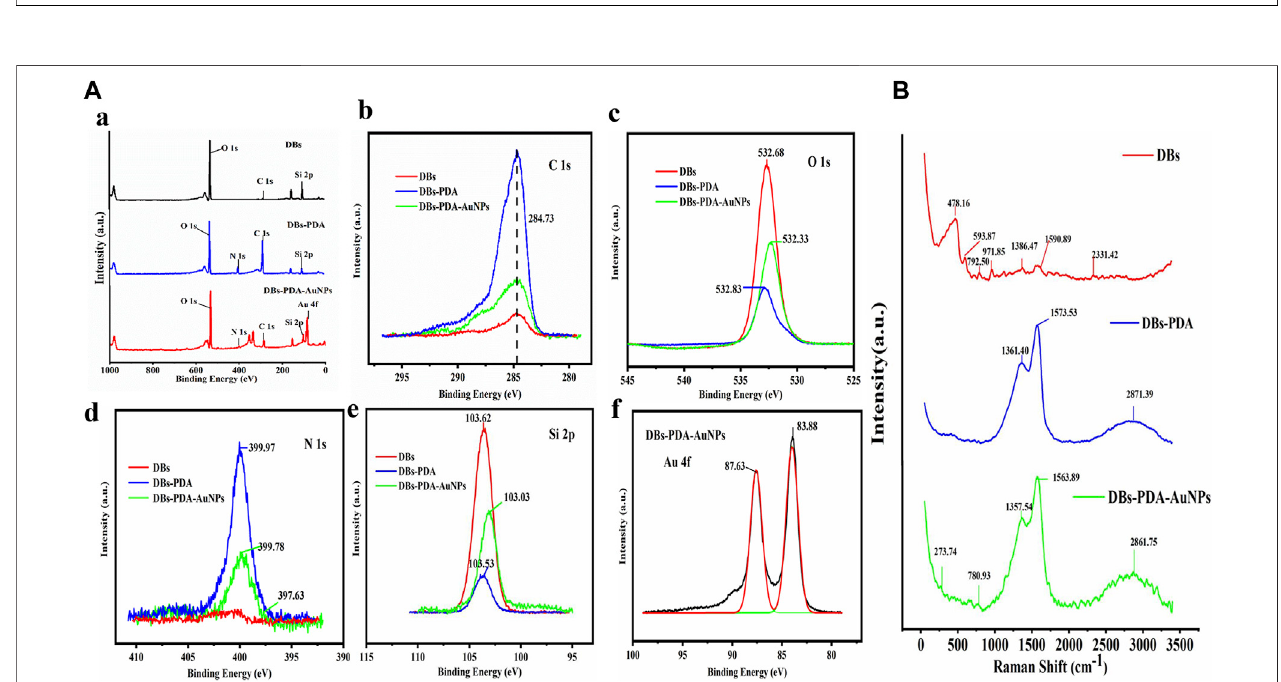
FIGURE 3 | (A) XPS spectra of DBs, DBs-PDA, and DBs-PDA-AuNPs. (a) XPS survey spectrum of DBs and PDA-coated DBs as well as AuNP-deposited DBs- PDA. (b) C 1s scanspectrum, (c) O 1s scanspectrum, (d) N 1s scanspectrum, (e) Si 2p scanspectrum,and (f) Au 4f scanspectrum. (B) SERS spectrum ofDBs, DBs-PDA, and